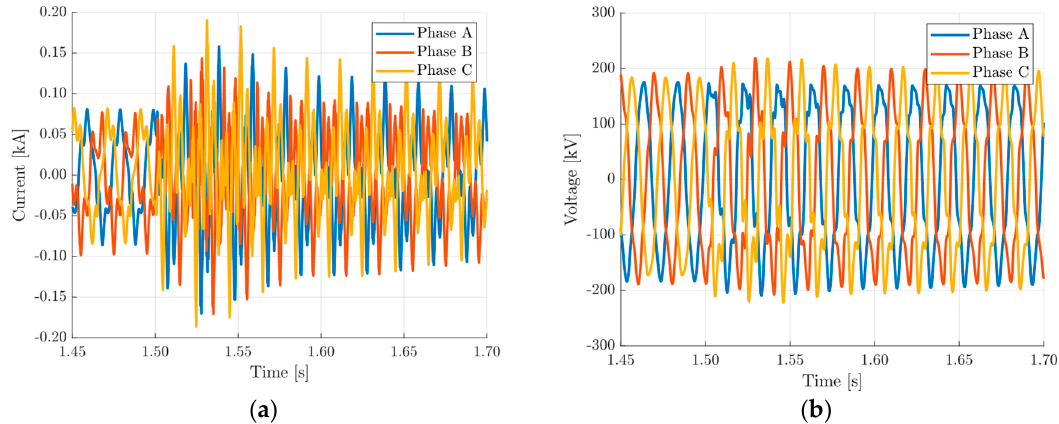
Figure 7. Simulation results with a synchronous generator as the self-start unit in the simplified benchmark system after closing breaker BRK1, thus energising the onshore transformer: current ( a ) and voltage ( b ) waveforms.